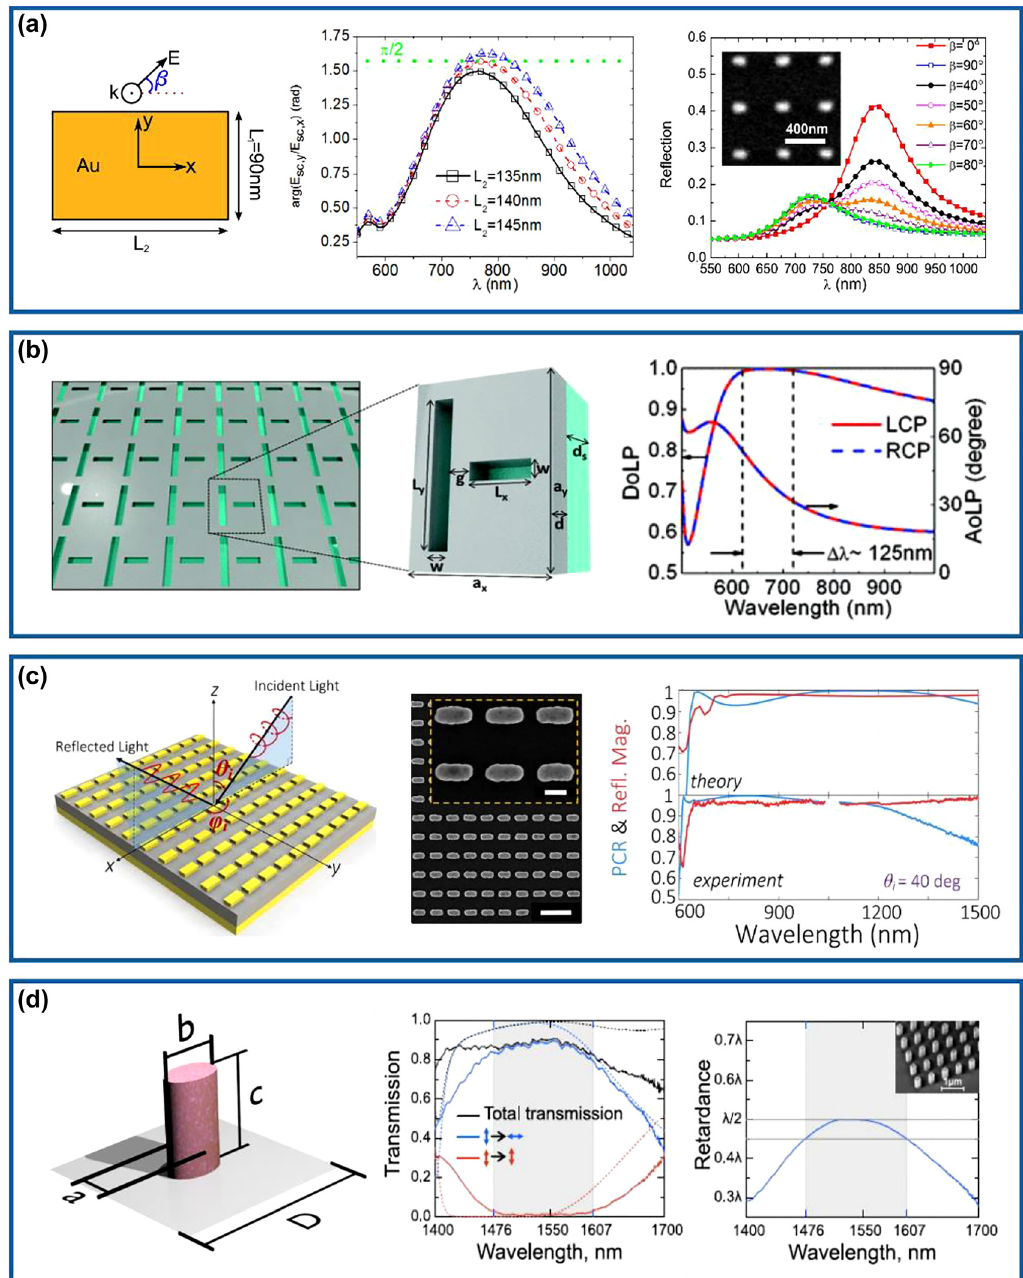
Figure 1: Metasurface-based conventional HWPs and QWPs. (a) Left panel: schematic of an Au brick-shaped meta-atom illuminated with a plane wave with the AoLP of β . Middle panel: simulated phase difference of the scattered electric fi elds for optimized nano-brick structures with different L 2 . Right panel: normalized re fl ection spectra for different β as a function of the wavelength. The inset shows the scanning electron microscopy (SEM) image of the fabricated Au bricks. Reprinted from Ref. [26]. (b) Left panel: schematic of the complementary plasmonic metasurface with nano slits. Right panel: DoLP and AoLP of the designednano-slit metasurface for LCP and RCP excited waves as a function of the wavelength. Reprinted from Ref. [27]. (c) Left panel: schematic of the MIM meta-QWP that converts a CP incident wave with an incident angle of ( θ i , φ = 0 ° ) into an LP output wave. Middle panel: SEM image of the fabricated meta-QWP. Right panel: theoretical and i experimental PCR and re fl ection magnitudes as a function of different wavelengths under one incident CP wave with θ i = 40 ° . Reprinted from Ref. [33]. (d) Left panel: schematic of the designed pillar-based Si meta-atom as a transmissive waveplate. Middle panel: experimental and theoreticaltransmissionspectra of the designed meta-HWP. Right panel: measured retardance of the fabricated Si meta-HWP as a function of the wavelength. The gray region marks the spectral range with a deviation from λ / 2 by less than 10%. The inset shows the SEM image of the fabricated sample. Reprinted from Ref.